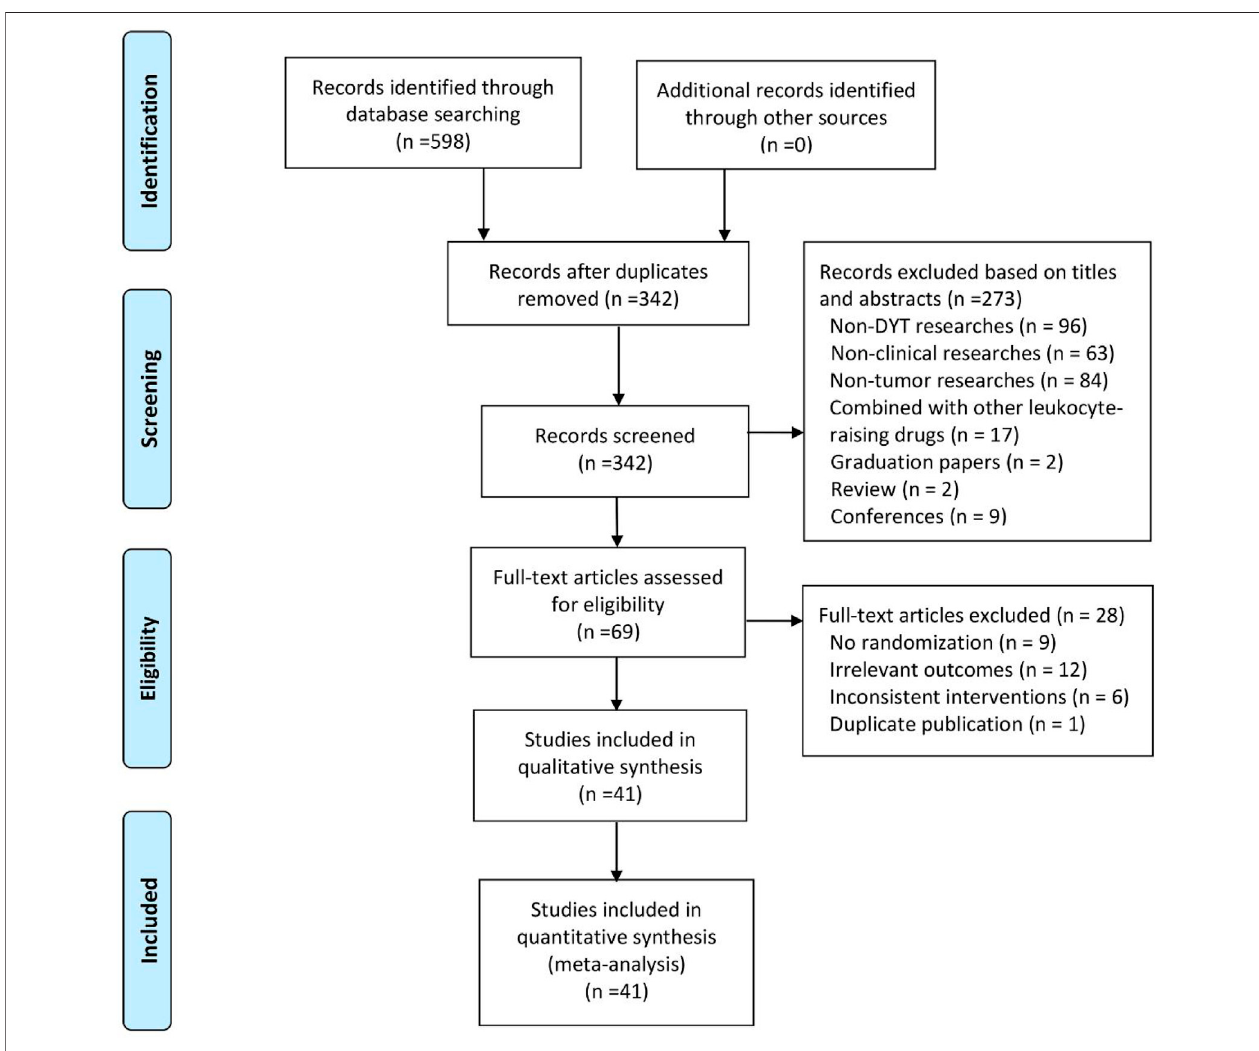
FIGURE 1 | Technology roadmap of bibliographic